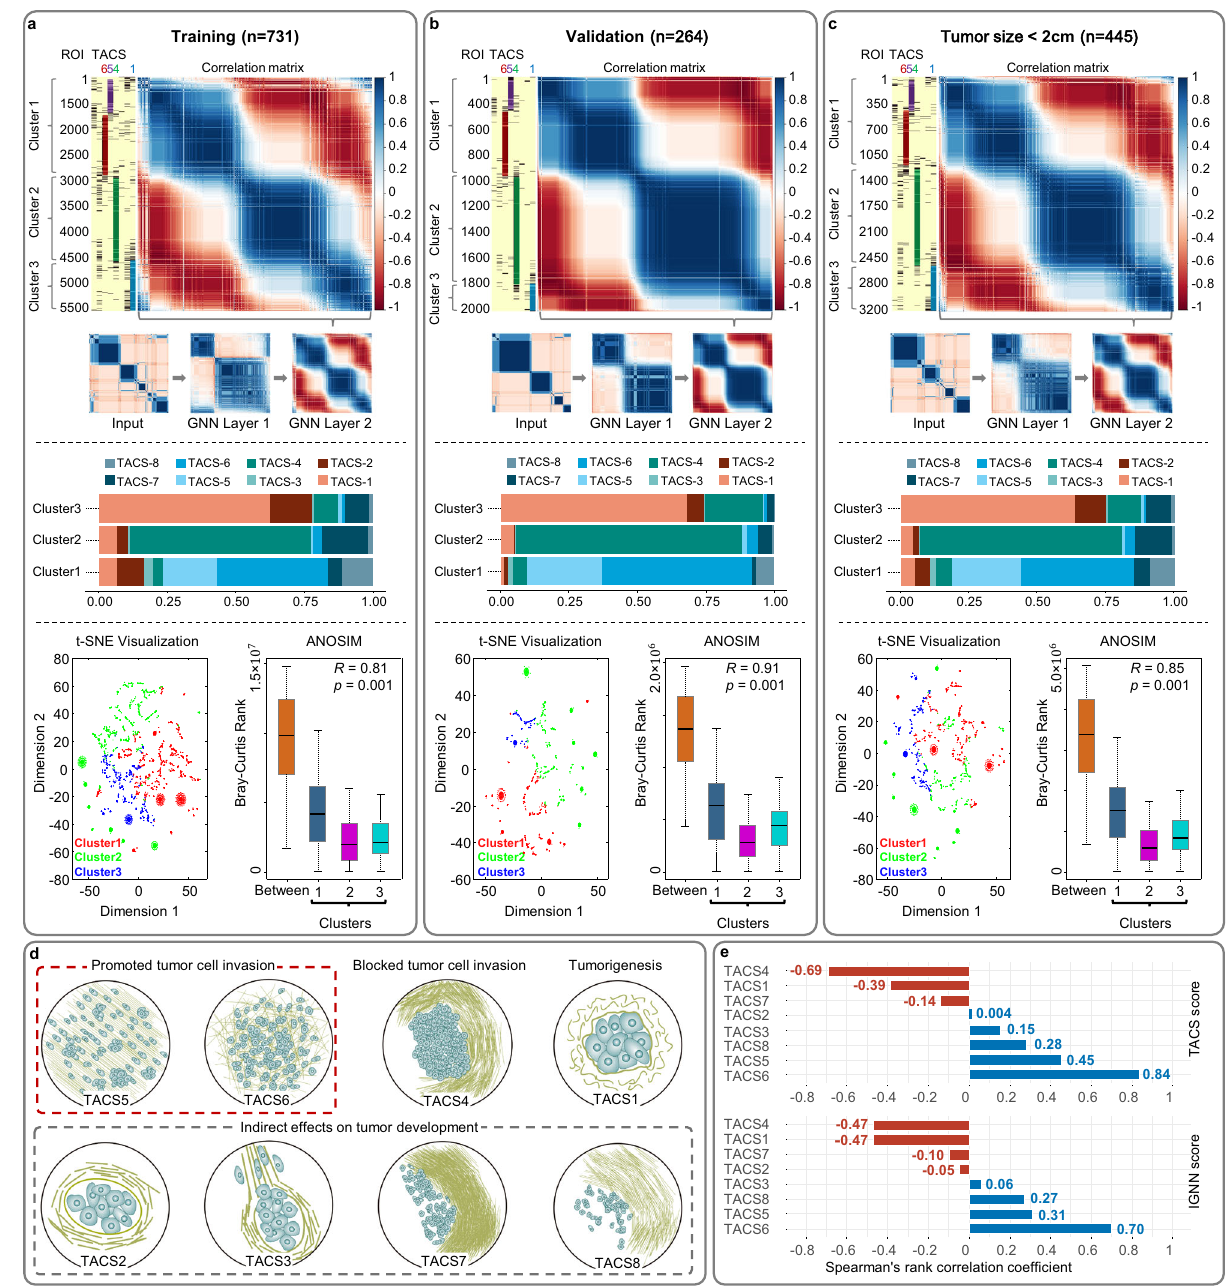
Fig. 4 Implicit interactions among TACSs interpreted by IGNN learning. a , b , c Automatic separation of patients into three clusters by the similarity of node state output from graph convolution layer 2 using Pearson correlation matrices of IGNN nodes (top), percentages of TACSs in the clusters (middle), learned node features projected to two dimensions for visualizing the clusters via t-distributed stochastic neighbor embedding (t-SNE technology) (bottom left), and ANOSIM that reveals the dissimilarities between the samples from different clusters (bottom right). In ANOSIM, the boxplots marked by “ Between ” , “ 1 ” , “ 2 ” and “ 3 ” show the Bray-Curtis rank distribution for ROI sample pairs between two clusters under comparison and within clusters 1-3, respectively. In boxplots, middle line represents the median value, the upper and lower boundaries of boxes indicate 25th and 75th percentile, the whiskers re fl ect 1.5 times of interquartile range, and the upper and lower tails indicate the maxima and minima. Wilcoxon rank sum test was performed to compare the signi fi cant difference between clusters without any adjustments for multiple comparisons, with statistic R ranges between the values − 1.0 to 1.0, wherein a value close to 1.0 suggests dissimilarity between clusters while a value <0 suggests greater dissimilarities within clusters than between clusters (observed R value over the null distribution was used to assess R statistic from exact p values, and the signi fi cance was de fi ned as p < 0.05). d Post hoc interpretations of the nature of TACS1-8 and their regional/spatial interactions. e Correlation analysis between individual TACSs and TACS score and IGNN score. ROI regions of interest, TACS (TACS1-8) tumor-associated collagen signatures, GNN graph neural network, IGNN intratumor graph neural network, t-SNE t-distributed stochastic neighbor embedding, ANOSIM Analysis of similarities. Source data are provided as a Source Data fi le.